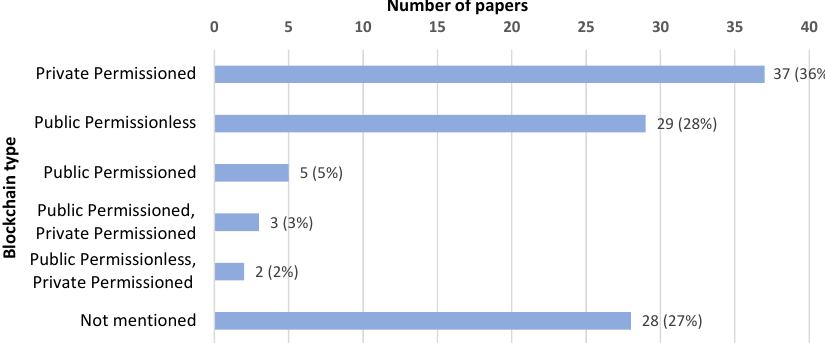
Figure 10. Types of blockchain presented in the papers included in our scoping